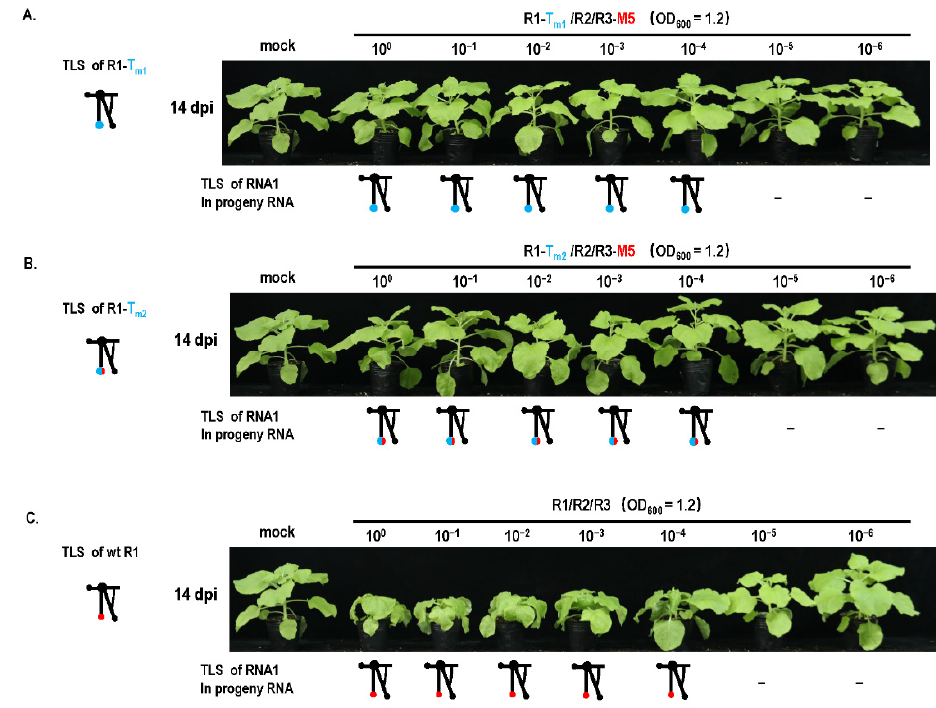
Figure 7. Effect of cell-to-cell movement on mutant repair in dilution inoculation assay. Mutation repair assay under dilution inoculation of ( A ) R1-T m1 /R2/R3-M5. R1—RNA1 of CMV Fny ; R2—RNA2 of CMV Fny ; R3-M5—3a mutation in RNA3 of CMV Fny . ( B ) R1-T m2 /R2/R3-M5. ( C ) Wild-type CMV.